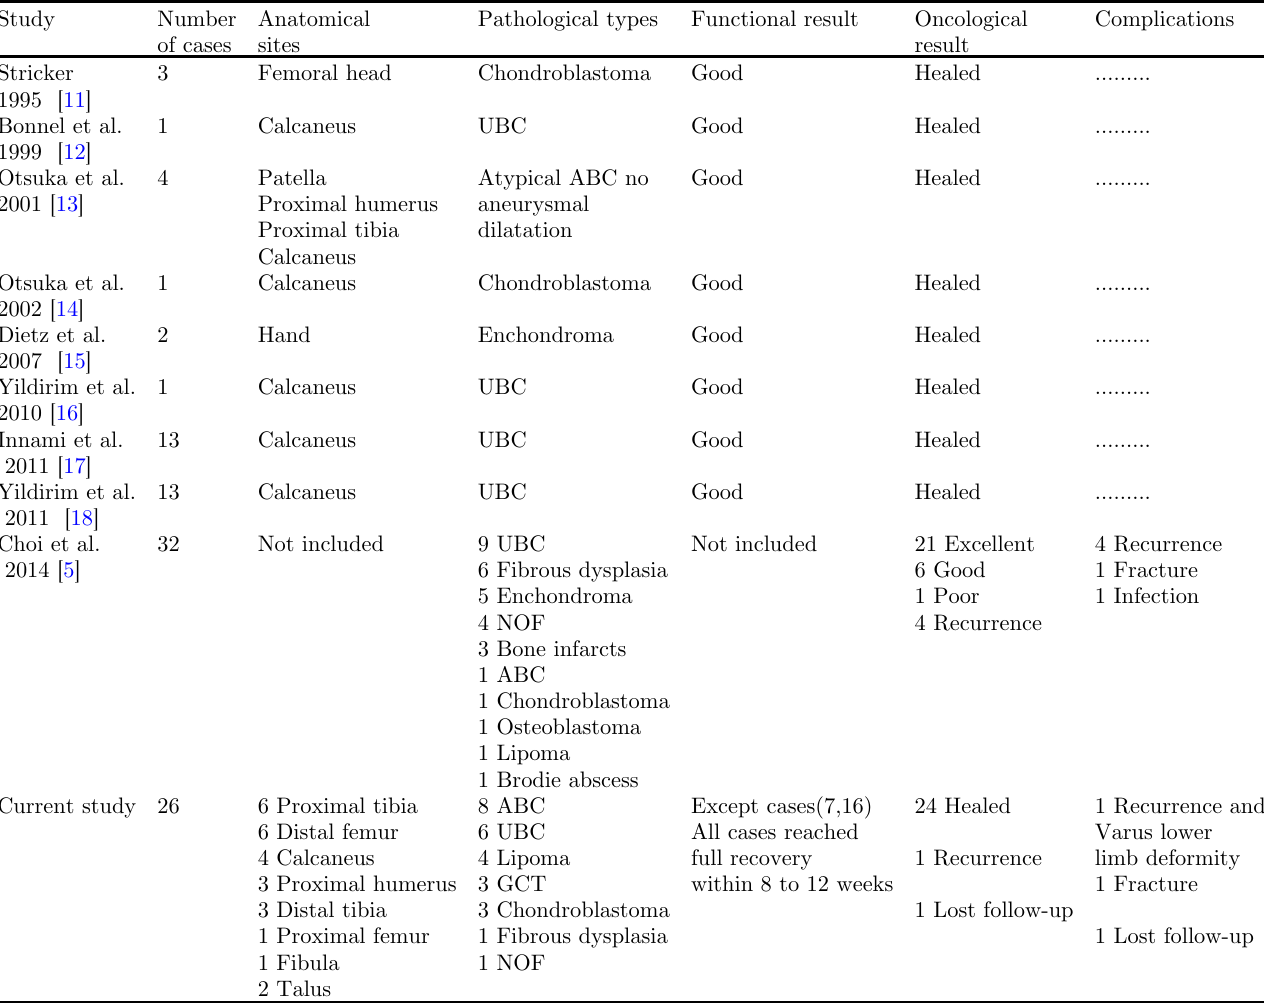
Table 2. A comparison of different clinical trials to the current study. of cases